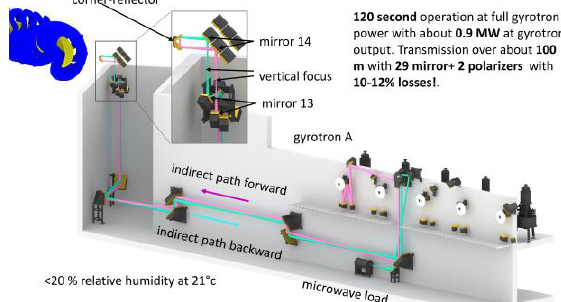
Fig.3. Sketch of the full power tests over twice the length of the transmission line with the A beam to the corner-reflector and via the F beam line back to the microwave load. The relative humidity was set below 20% at